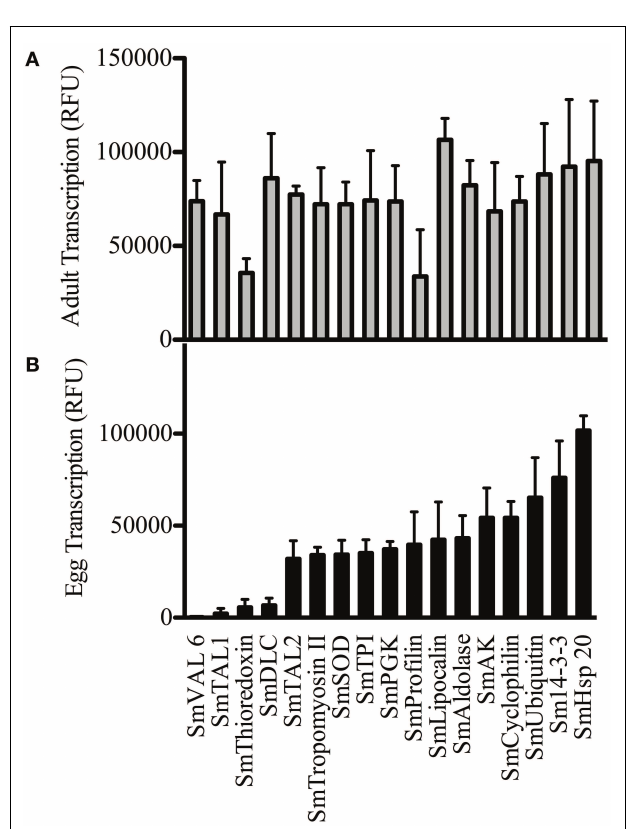
FIGURE 5 | Differential transcription of antigens in S. mansoni adult worms (A) and eggs (B) as determined by previously published microarray studies (35) . Levels of antigen transcription were expressed as relative fluorescent units